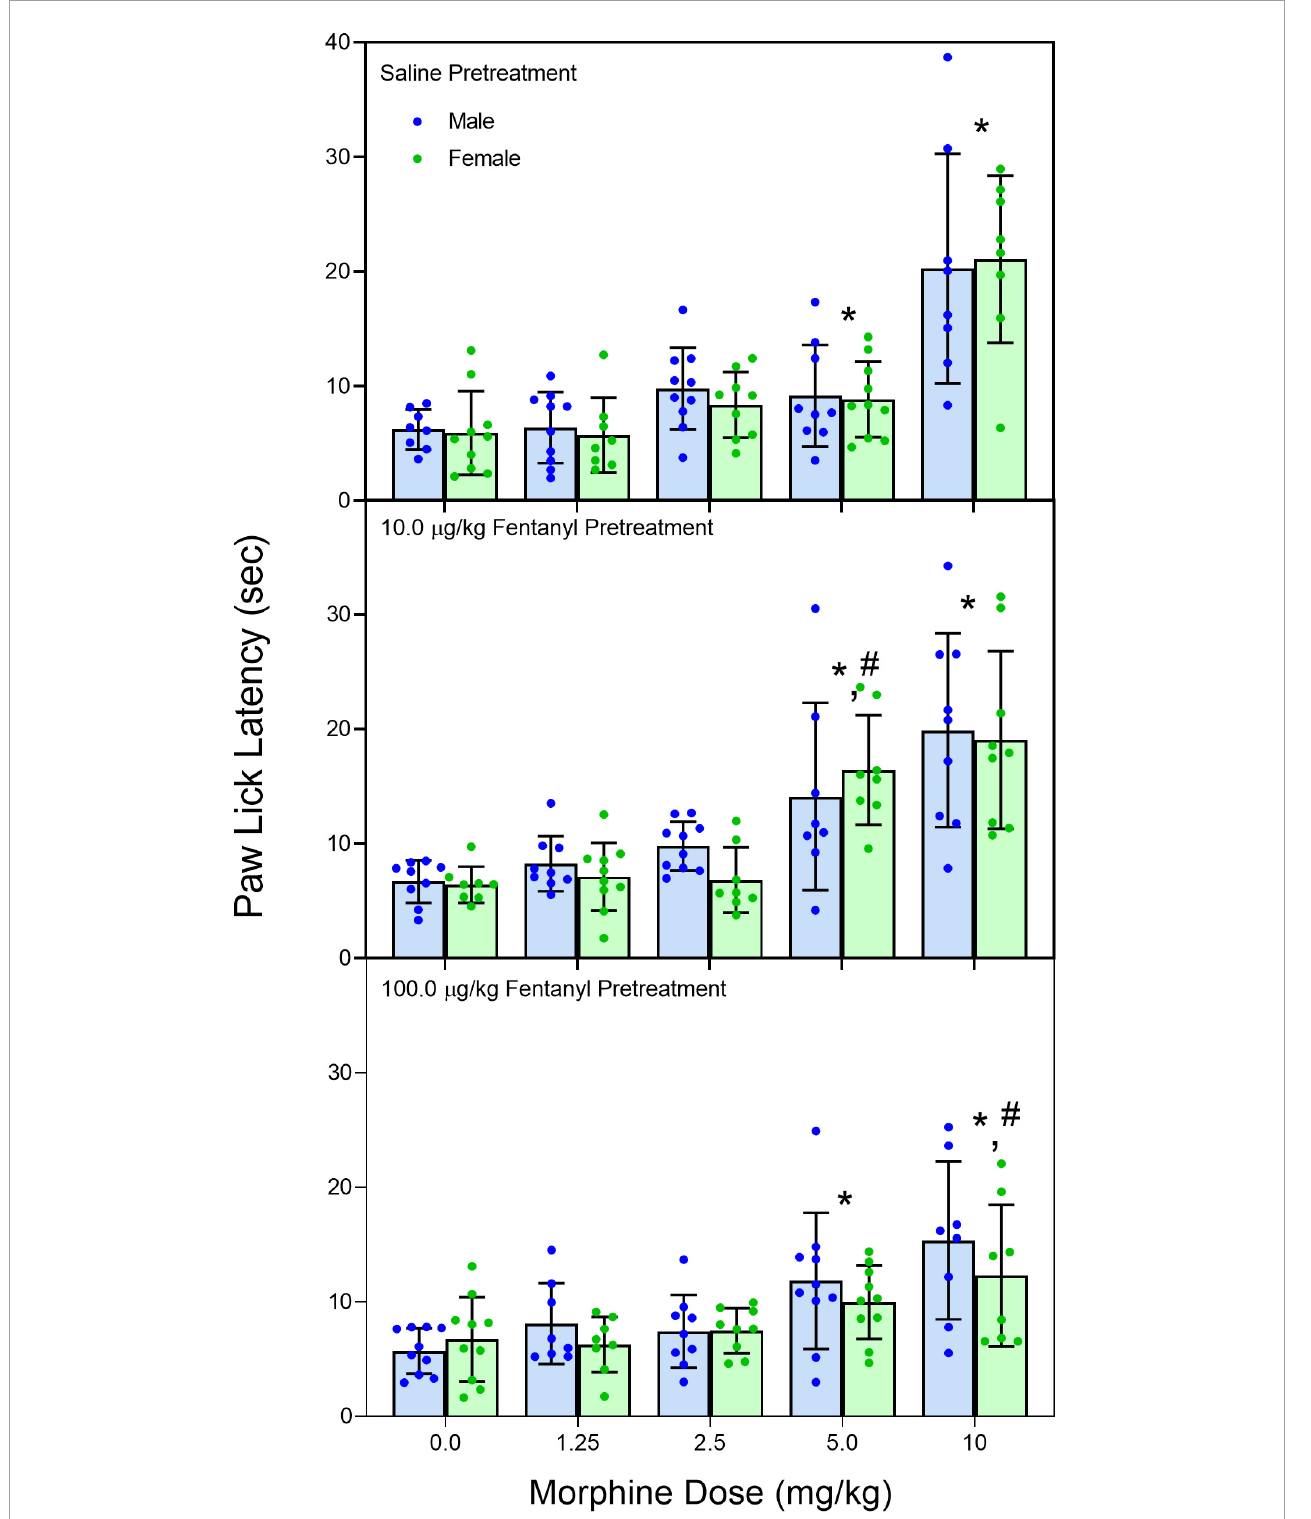
FIGURE3 Mean (+SE) paw-lick latencies of PD 60 male and female rats ( n = 8–9/sex). Rats were pre-treated with fentanyl (10 or 100 µ g/kg) or saline from PD 4 to PD 9 and injected with morphine (0, 1.25, 2.5, 5.0, or 10 mg/kg, sc) on PD 60. *Significantly different from 0 mg/kg morphine. # Significantly different from saline-pre-treated rats in the same morphine drug